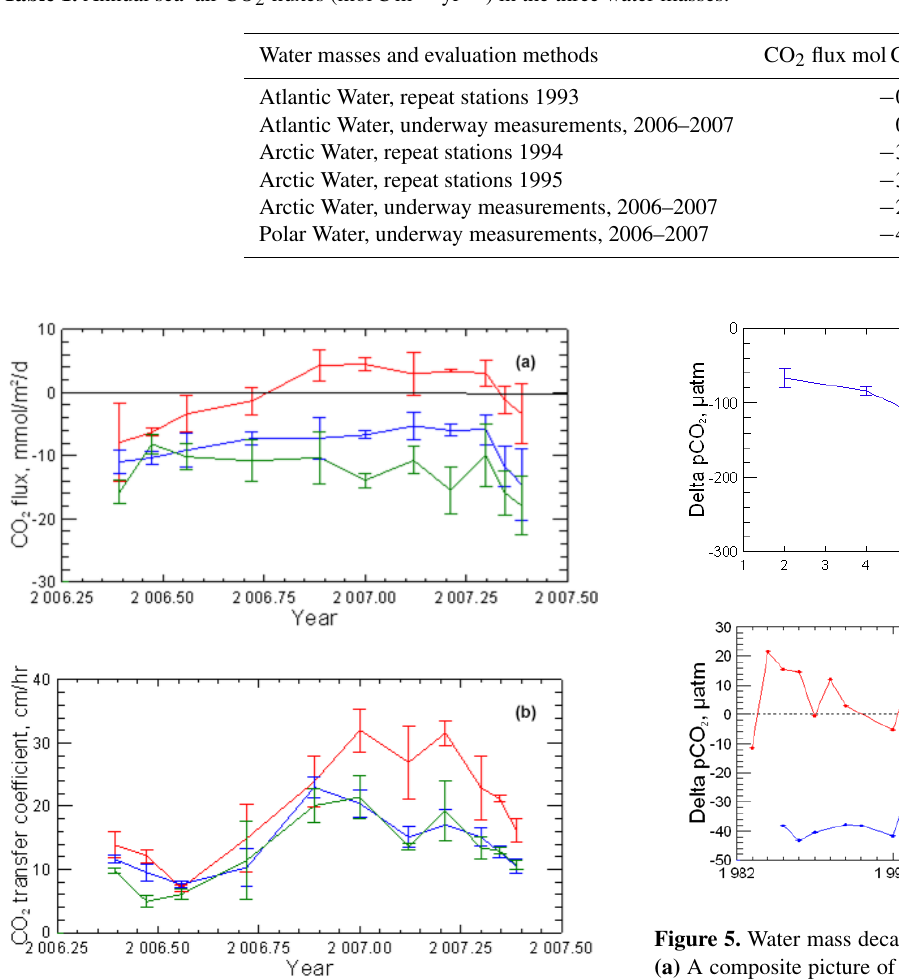
Table 1. Annual sea–air CO 2 fluxes (molCm − 2 yr − 1 ) in the three water masses.